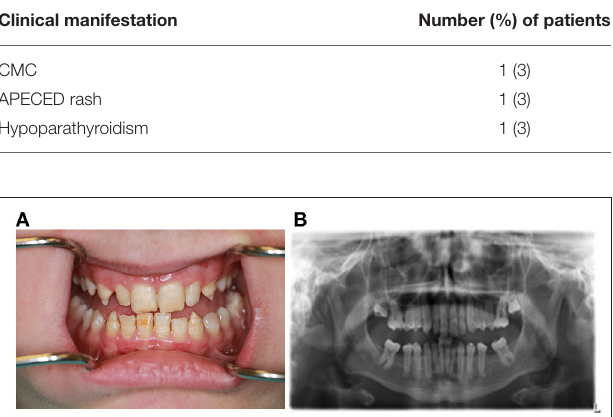
TABLE 2 | Frequency of diseases appearing in combination with enamel hypoplasia as the first two consecutive clinical manifestations in 35 patients with APECED.